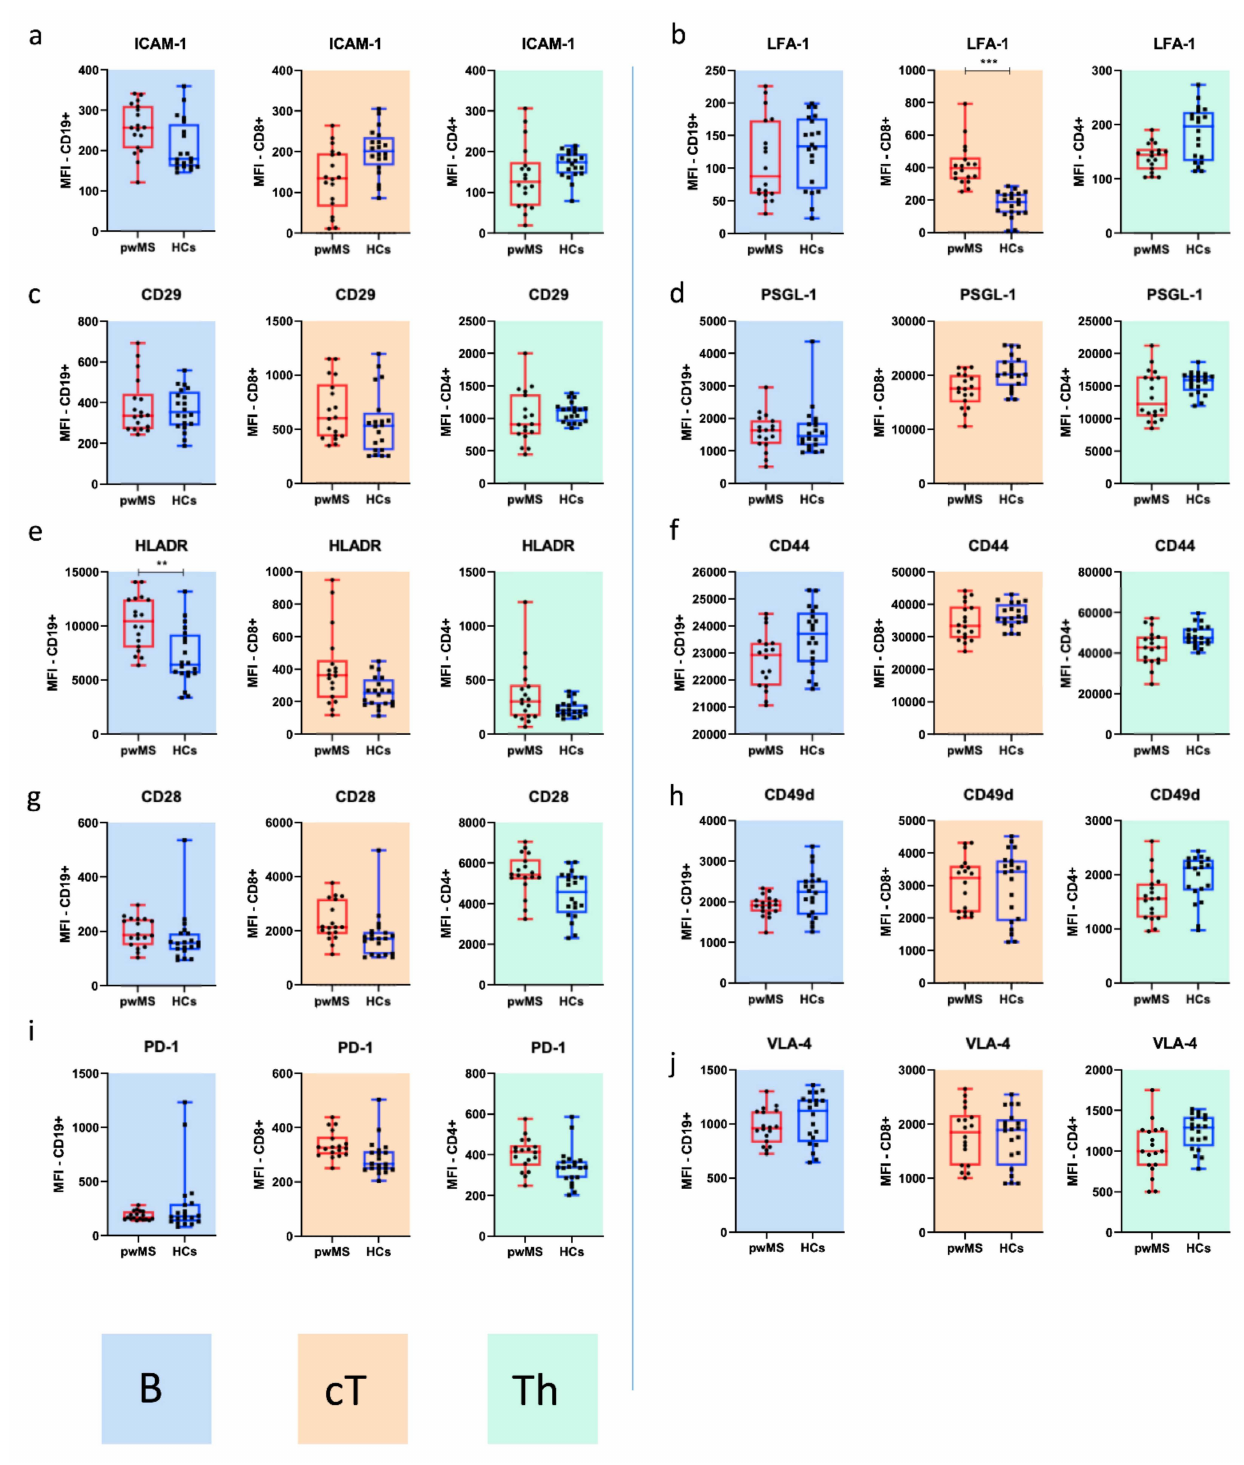
Figure 2. Baseline characteristics for adhesion and costimulatory surface molecules in healthy controls (HCs) and patients with MS (pwMS) ( a – j ): surface density (MFI) of B cells/CD19+ (blue graphs), cytotoxic T cells/CD8+ (brown graphs) and T helper cells/CD4+ (green graphs). The molecular surface expression patterns were analysed by flow cytometry. Surface intensity staining for LFA-1 (CD8+ ( b )) and HLADR (CD19+ ( e )) was increased within the MS cohort. Legend: Box-and-whisker plots show the median, interquartile range and minimum–maximum range. ** p ≤ 0.01 and *** p ≤